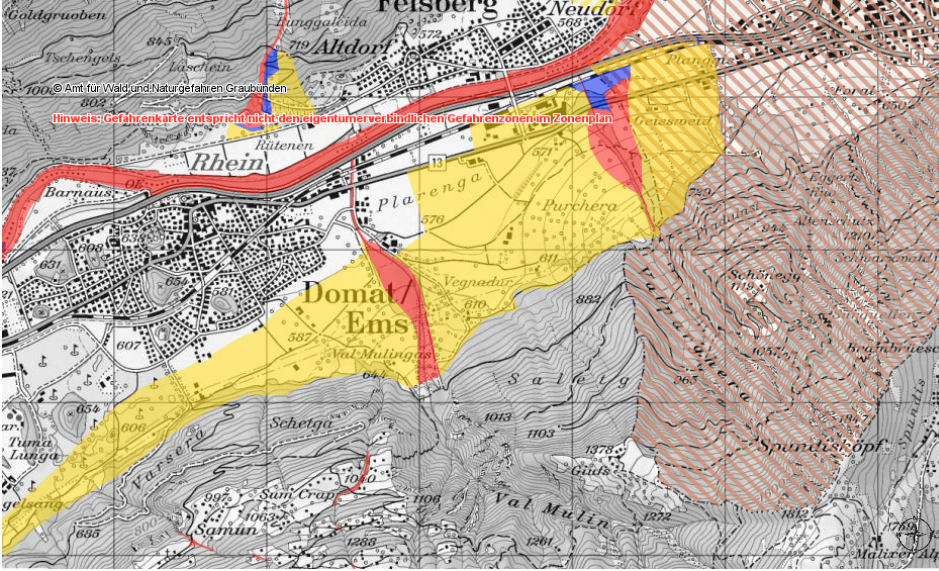
Figure 3. Natural hazard risk map of Felsberg: rock fall risk zones (Latitude: 46.845238 | Longitude: 9.47123; © Canton of Grisons).